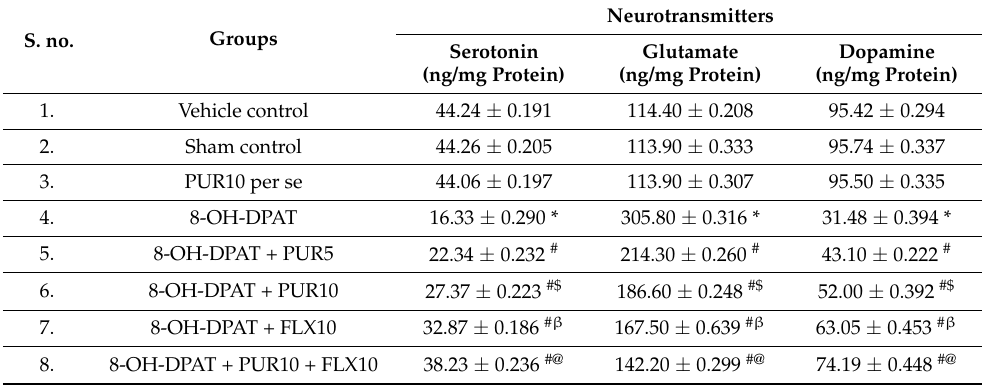
Table 4. Effect of purmorphamine on neurotransmitter levels in the brain samples of 8-OH